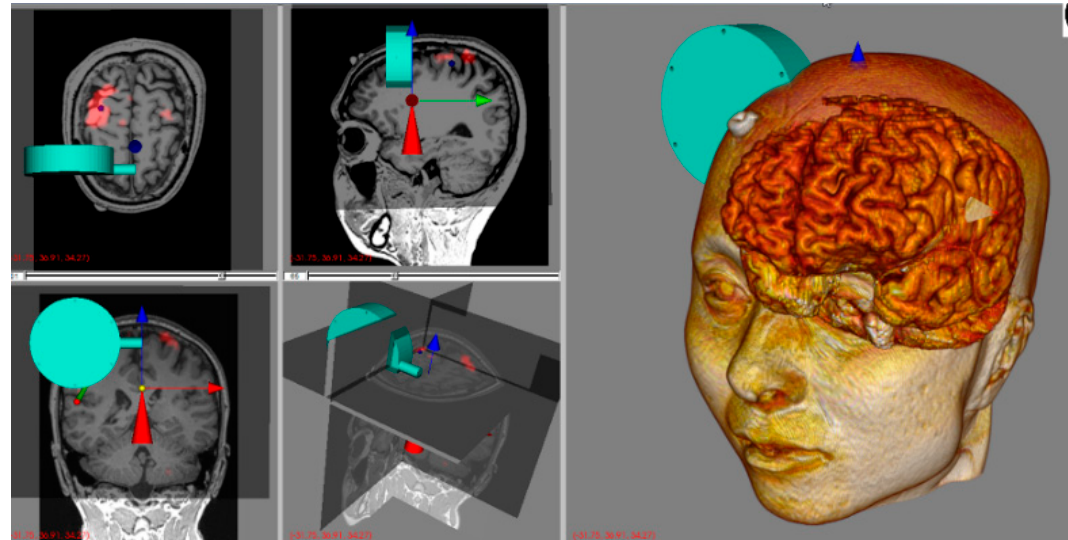
Figure 6. Graphic user interface (GUI) of navigation program. It displays three 2D windows (axial, sagittal, coronal planes) and two 3D windows. One of 3D windows is combined three 2D planes in the 3D space. In the other 3D window, 3D rendered head and brain model are shown. A transducer model, a red cone, and world coordinate are displayed in every window. The transducer (cyan) is not registered yet.